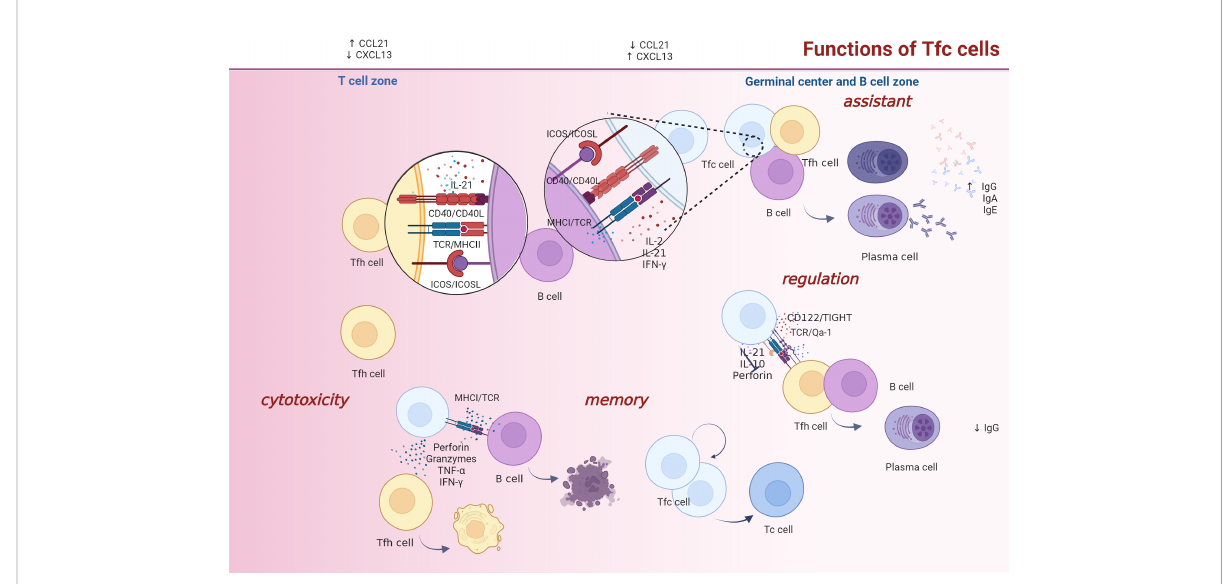
FIGURE 3 Tfc/Tfh/B cell interactions. Tfc cell functions are categorized as cytotoxic, memory, assistance, and regulatory. Firstly, Tfc cells perform their killing functions mainly through their cytokine secretion. They secrete IFN- g , TNF- a , granzymes and perforin to eliminate infected Tfh and B cells. Secondly, under chronic infection settings, Tfc cells serve as a CD8+ T cell storage pool, which maintain stemness and differentiate into effector CD8+ T cells. Thirdly, Tfc cells help B cells produce antibodies and antibody isotype class switching via cytokines IL-2, IL-21, IFN- g or with the help of CD40L/CD40, ICOSL/ICOS, and TCR/MHC I interactions. Fourthly, under a perforin-dependent and IL-10-independent condition, Tfc cells suppress Tfh cell helper function and antibody response through ICOSL/ICOS, CD122/TIGHT and TCR/Qa-1, and inhibit antibody responses to sustain self-maintenance and suppress immunity. Moreover, the IFN- g , TNF- a , and granzymes A/B/K expression of Tfc cells increase, inhibit Tfh cell function in a cell-cell contact independent manner, and inhibit Tfh-dependent plasma blast cell differentiation indirectly. FDC, follicular dendritic cell; Tfh, follicular helper; Tc, cytotoxic T; Tfc, follicular cytotoxic